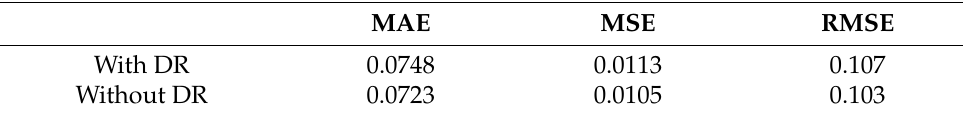
Table 7. MLR with dimensionality reduction: performance of the model on training